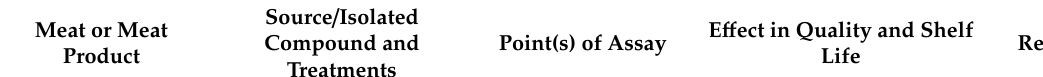
Table 6. Antioxidant and antimicrobial activity of polyphenol-rich extracts from Olea europaea and isolated compounds in meat and meat